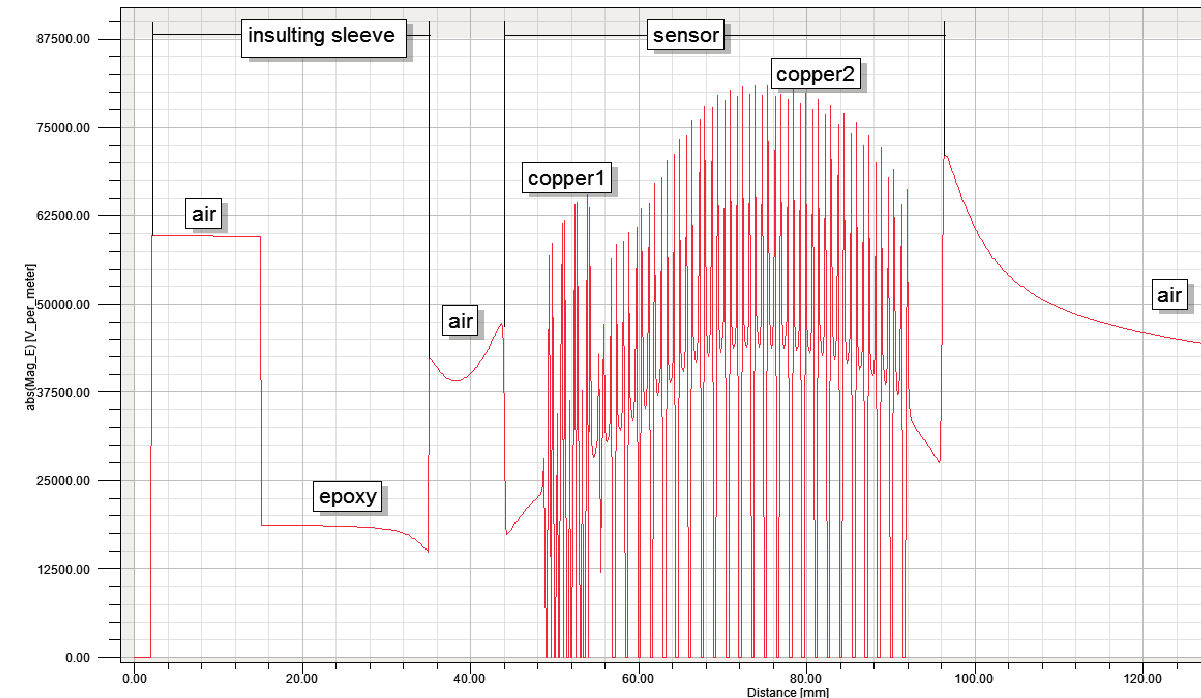
Figure 15. Electric field distribution diagram.